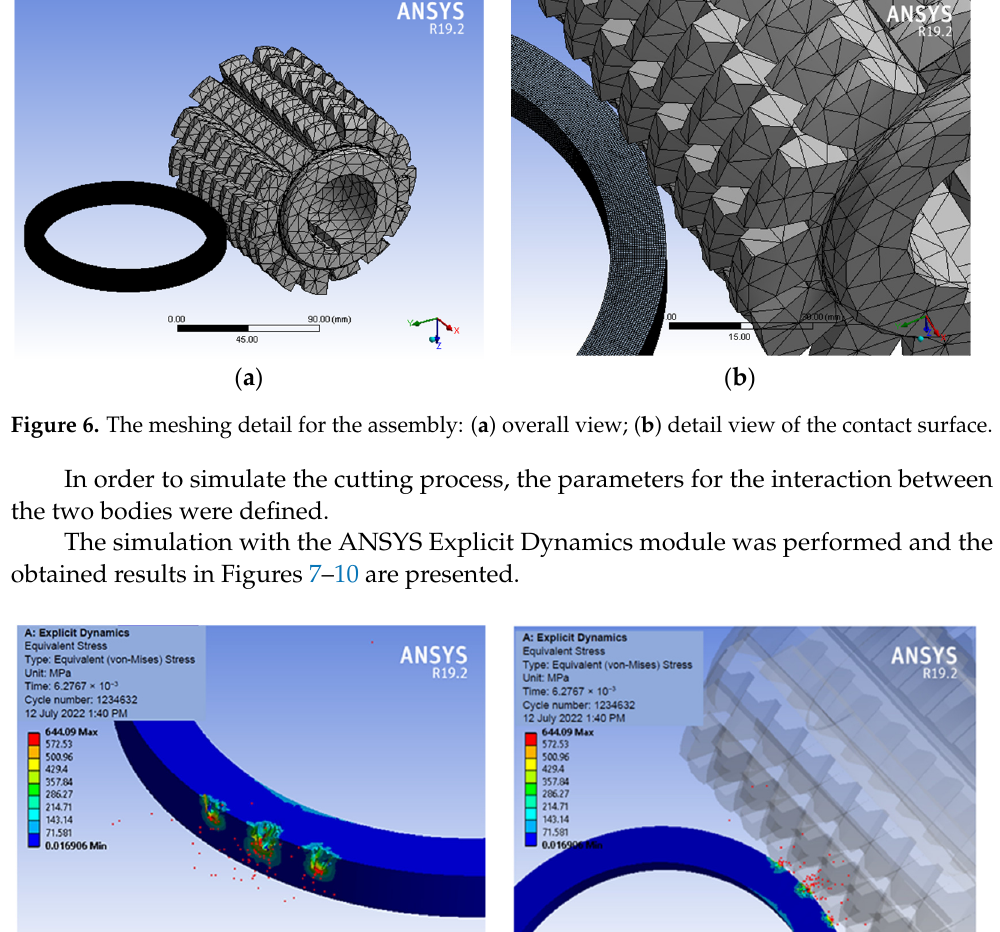
Figure 5. Geometric model for the assembly.